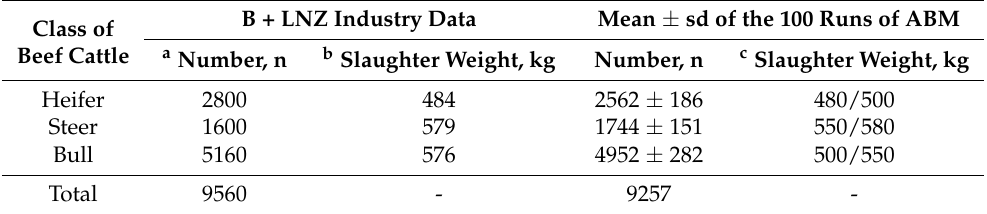
Table 2. Mean and standard deviation (sd), final slaughter weight of traditional dairy-origin beef cattle in the ABM and actual reported B+LNZ * numbers (the number represented 1% of dairy-origin beef cattle processed in New Zealand based on the average of 2019 and 2020 processing